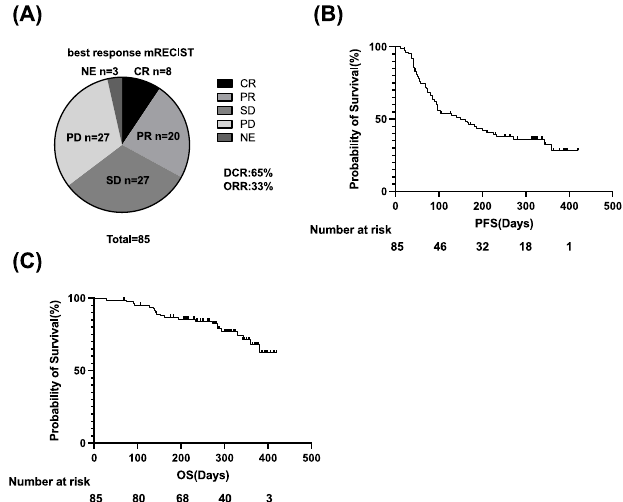
Figure 1. Clinical outcome of Atezo/Bev treatment in 85 u-HCC patients. ( A ) The best response to Atezo/Bev was assessed by mRECIST. ( B , C ) Kaplan–Meier curves of progression-free survival (PFS) ( B ) and overall survival (OS) ( C ). u-HCC, unresectable hepatocellular carcinoma; Atezo/Bev, Atezolizumab and bevacizumab; CR, complete response; PR, partial response; SD, stable disease; PD, progressive disease, NE, not evaluated; DCR, disease control rate; ORR, overall response rate. 3.2. Patients with High Plasma cfDNA Levels Show a Significantly Lower ORR and Shorter PFS and OS Than Those with Low cfDNA Levels We first evaluated the potential of cfDNA levels to predict the efficacy of Atezo/Bev therapy in u-HCC patients. Pretreatment plasma cfDNA levels were weakly associated with AFP levels and maximal tumor size (Supplementary Figure S1). We then divided patients into two groups based on the median cfDNA levels (cfDNA high vs. cfDNA low). Patients with high cfDNA levels showed significantly higher ALBI scores than those with low cfDNA levels (Supplementary Table S2). Regarding the treatment response to Atezo/Bev therapy, the ORR and DCR were 22.5% and 57.5% in the cfDNA high group and 45.2% and 76.2% in the cfDNA low group, respectively (Figure 2A,B). Patients with high cfDNA levels showed a significantly lower ORR than those with low cfDNA levels (Figure 2A). PFS and OS were also significantly shorter in patients with high cfDNA levels than in patients with low cfDNA levels (Figure 2C,D).